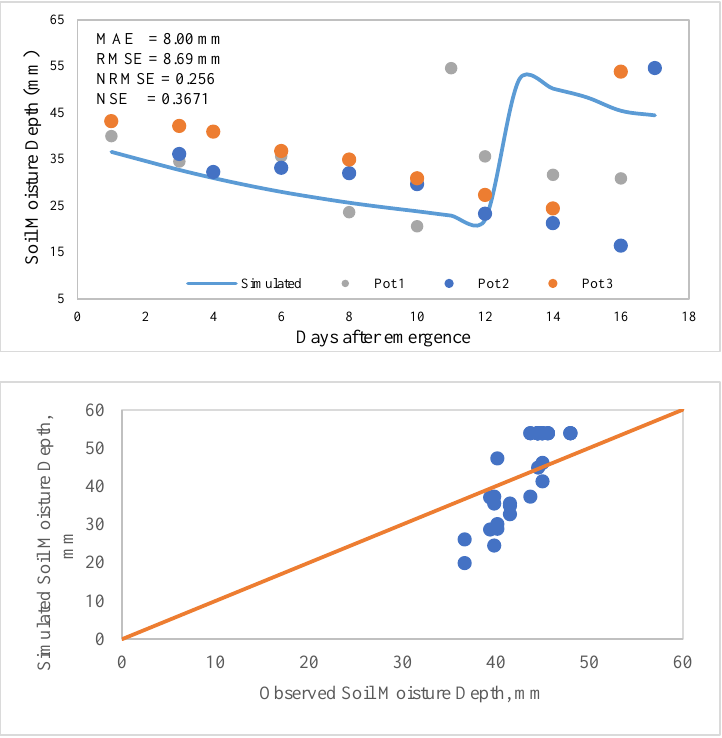
Figure 5. Simulated and observed soil moisture depth from pot experiments.